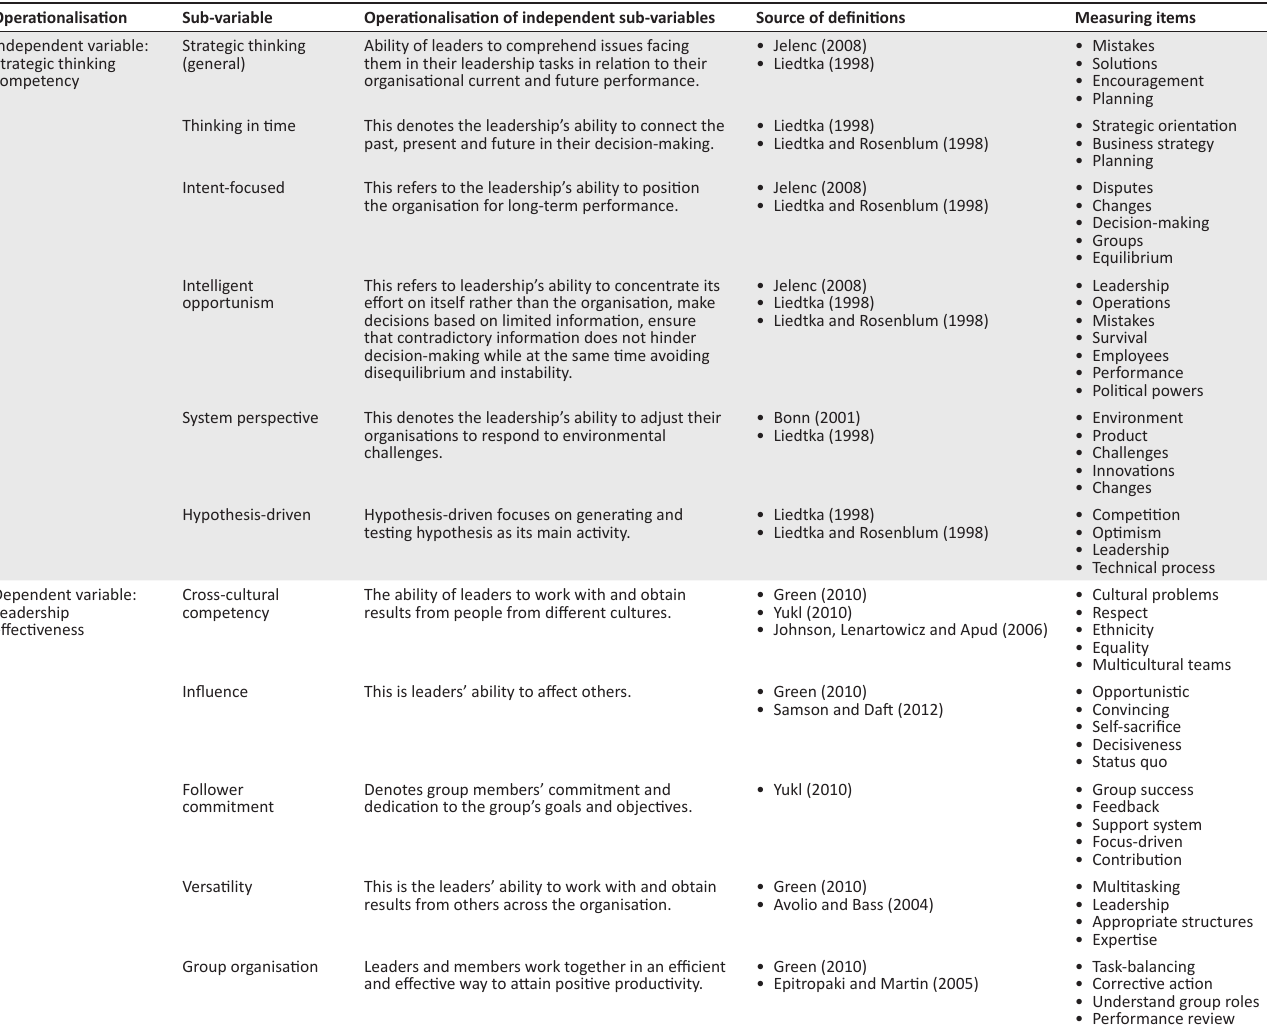
TABLE 3: Operationalisation of the independent and dependent variables.